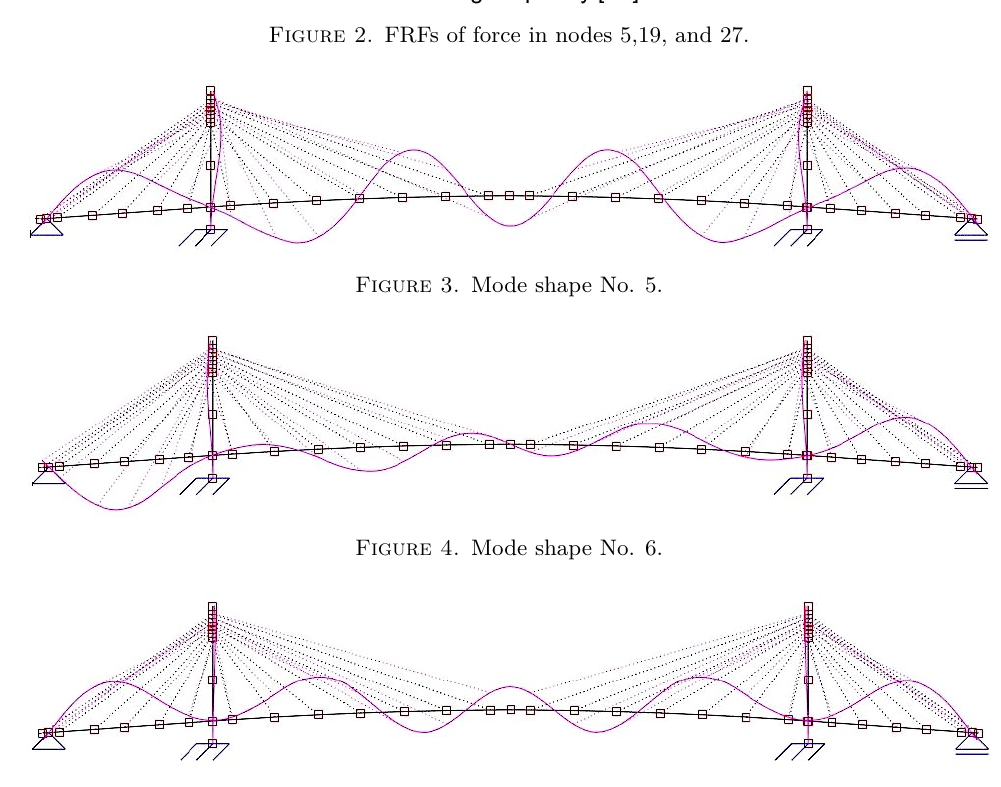
Figure 5. Mode shape No.